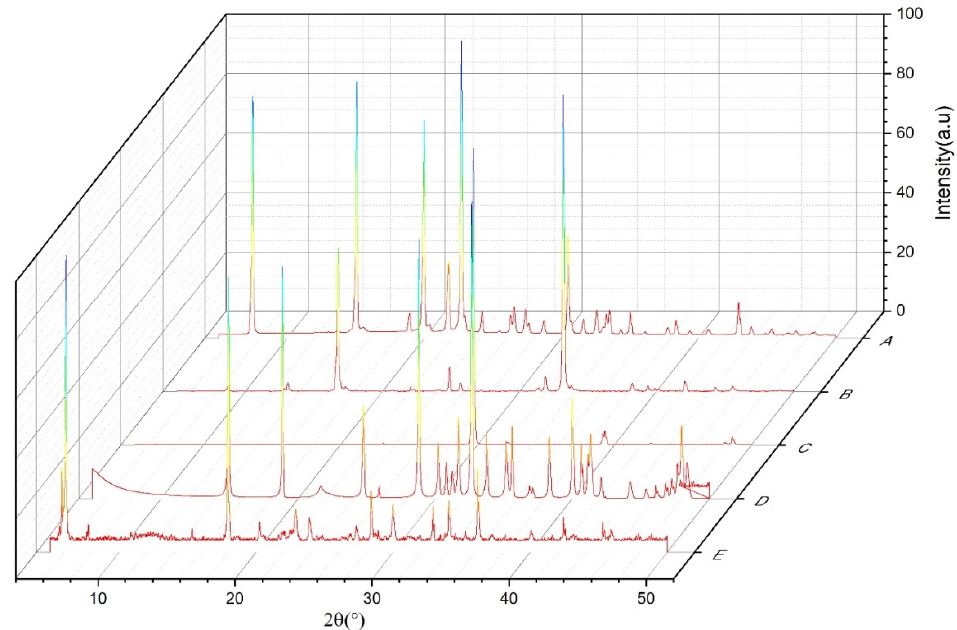
Figure 8. X-ray powder diffraction patterns of the reactants of cyclohexylammonium thiocyanate ( A ), sodium thiocyanate ( B ), and nickel nitrate hexahydrate ( C ), byproduct of sodium nitrate ( D ), and the experimental of (C 6 H 11 NH 3 ) 4 [Ni(NCS) 6 ] · 2H 2 O ( E ).